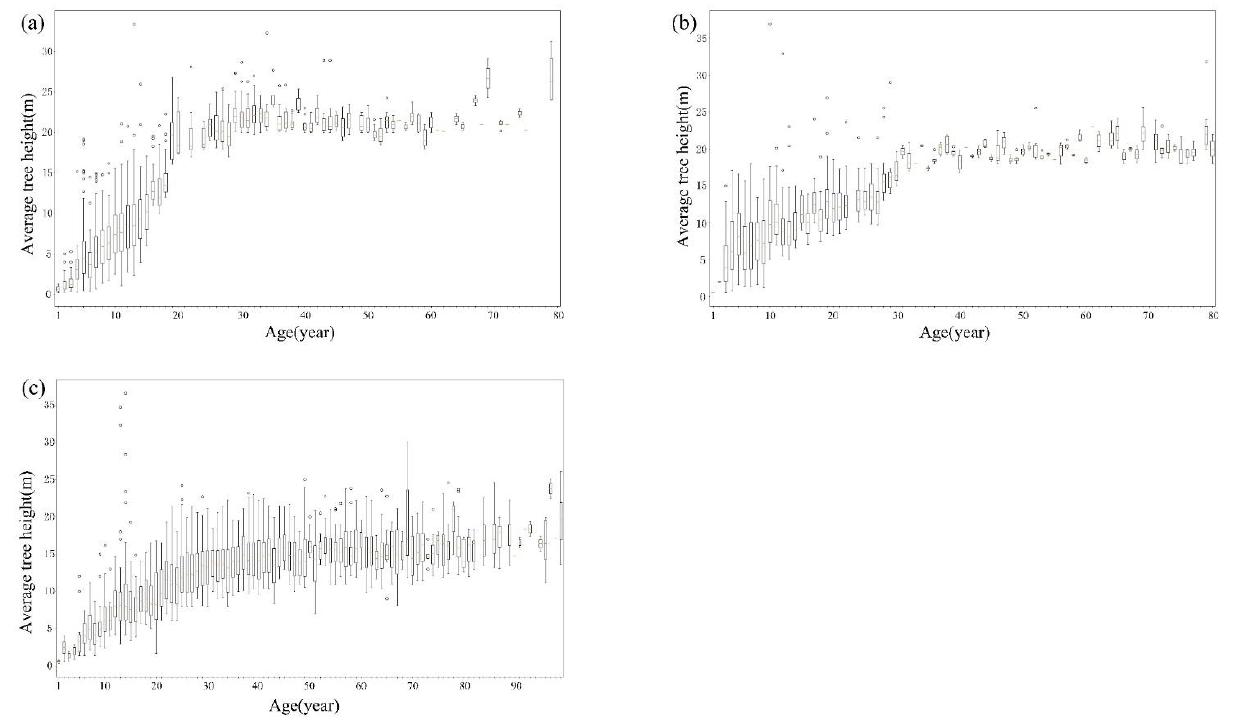
Figure 4. Box plot of the average tree height corresponding to each age. ( a ) Needleleaf forest. ( b ) Broadleaf forest. ( c ) Mixed forest.